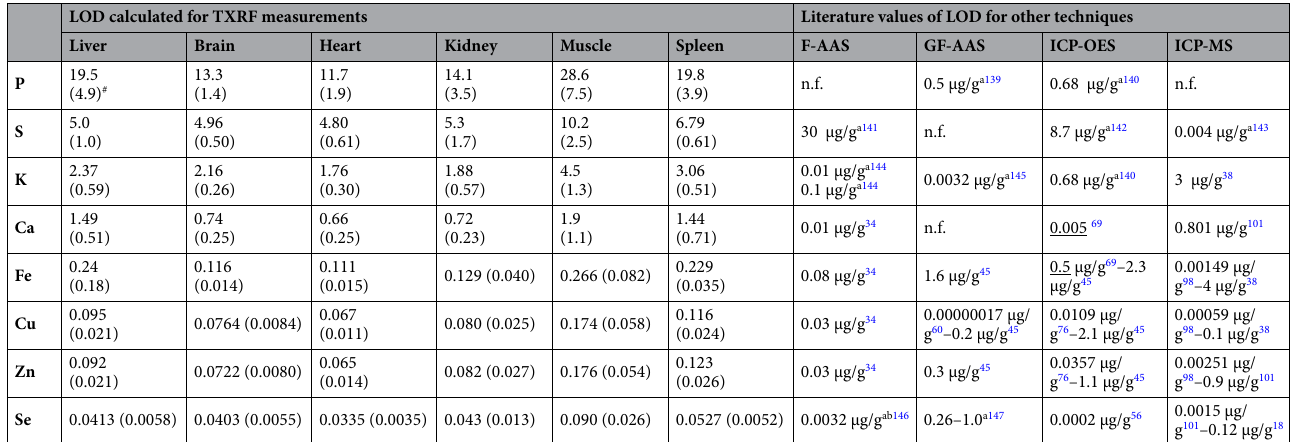
Table 6. Comparison of LODs of elements in [μg/g] obtained for examined organs using TXRF with the literature values for other analytical techniques. # LOD in [μg/g] together with the uncertainty calculated as standard deviation; a Value from the paper that does not concern the analysis biomedical samples; b Determined using HG-AAS; n.f. value not found in the discussed papers or not expressed in consistent